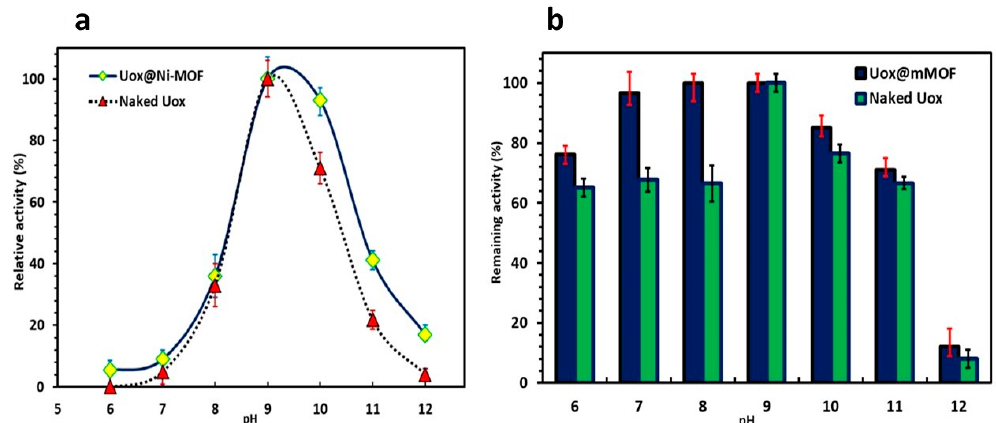
Figure 9. Analysis of the optimum pH and the pH stability of Uox preparations. ( a ) shows the level of activity of Uox and Uox@NimMOF samples at various pHs. ( b ) presents the pH stability results obtained for the free and immobilized Uox samples.